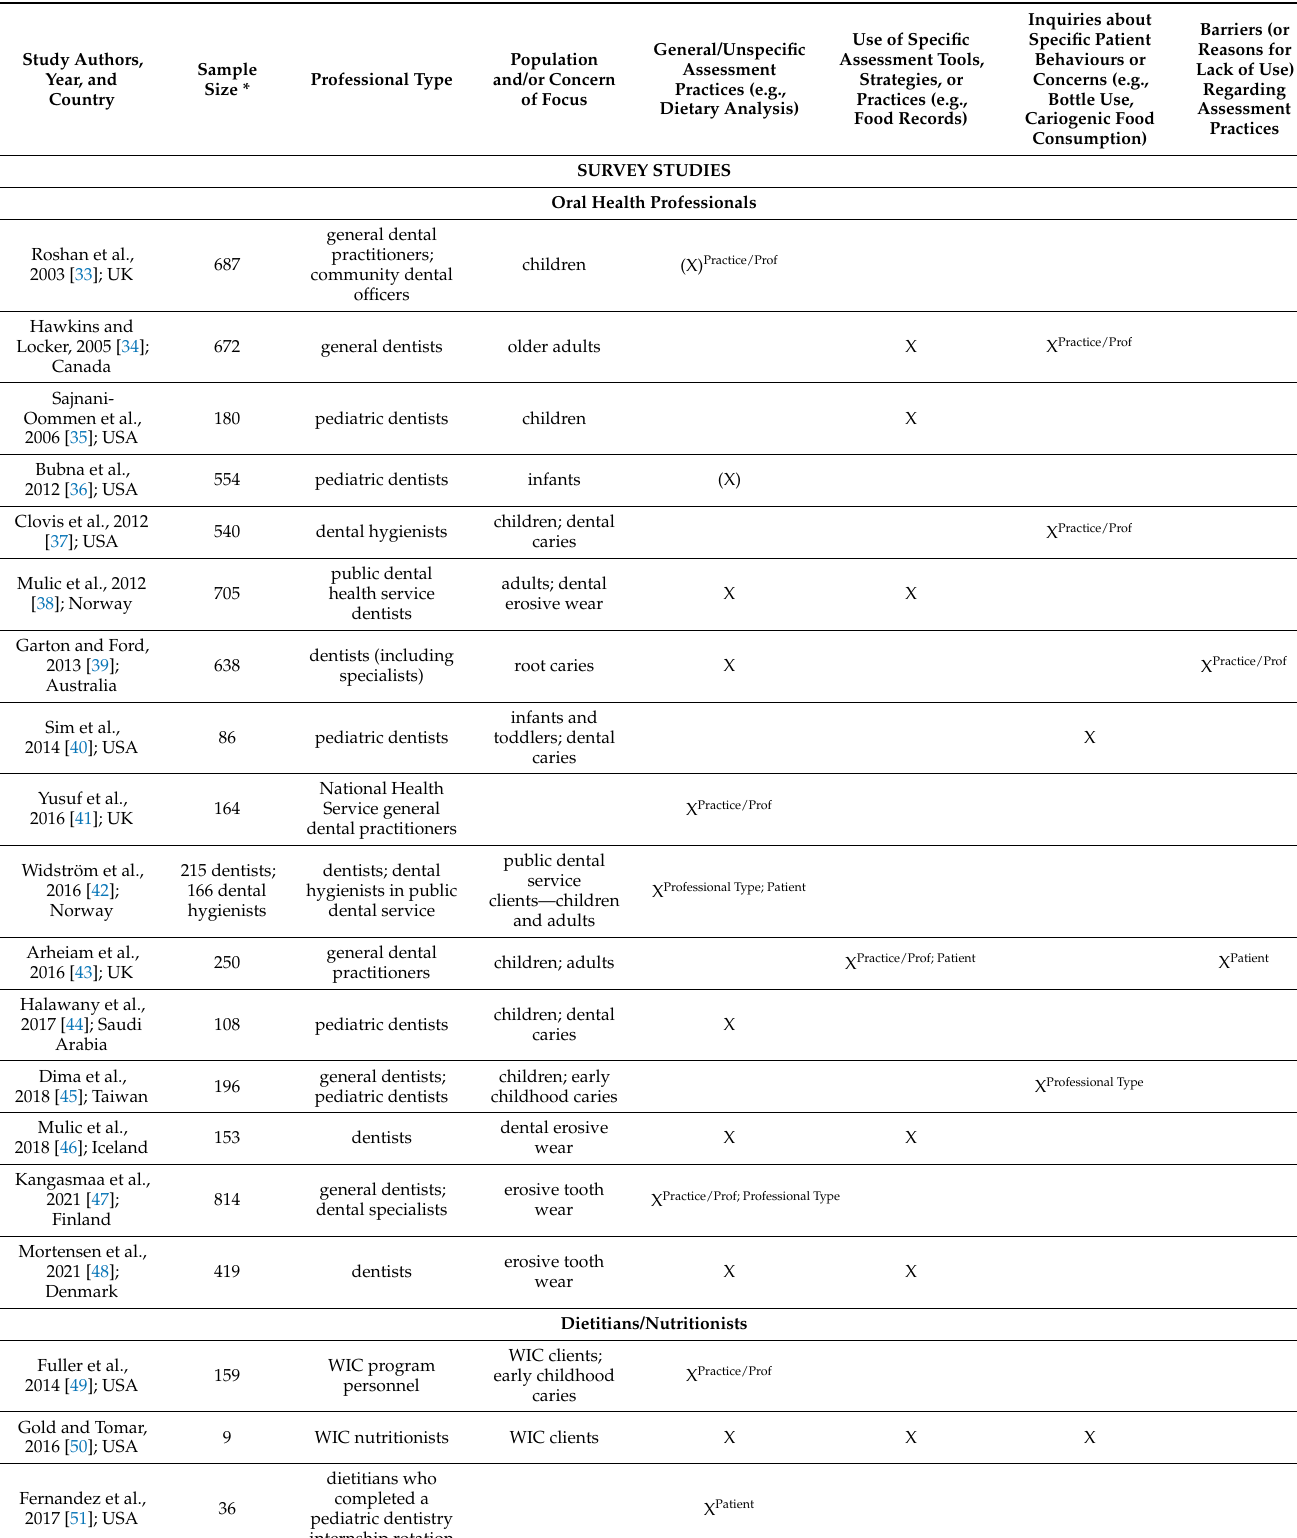
Table 3. Assessment practice information reported in the included